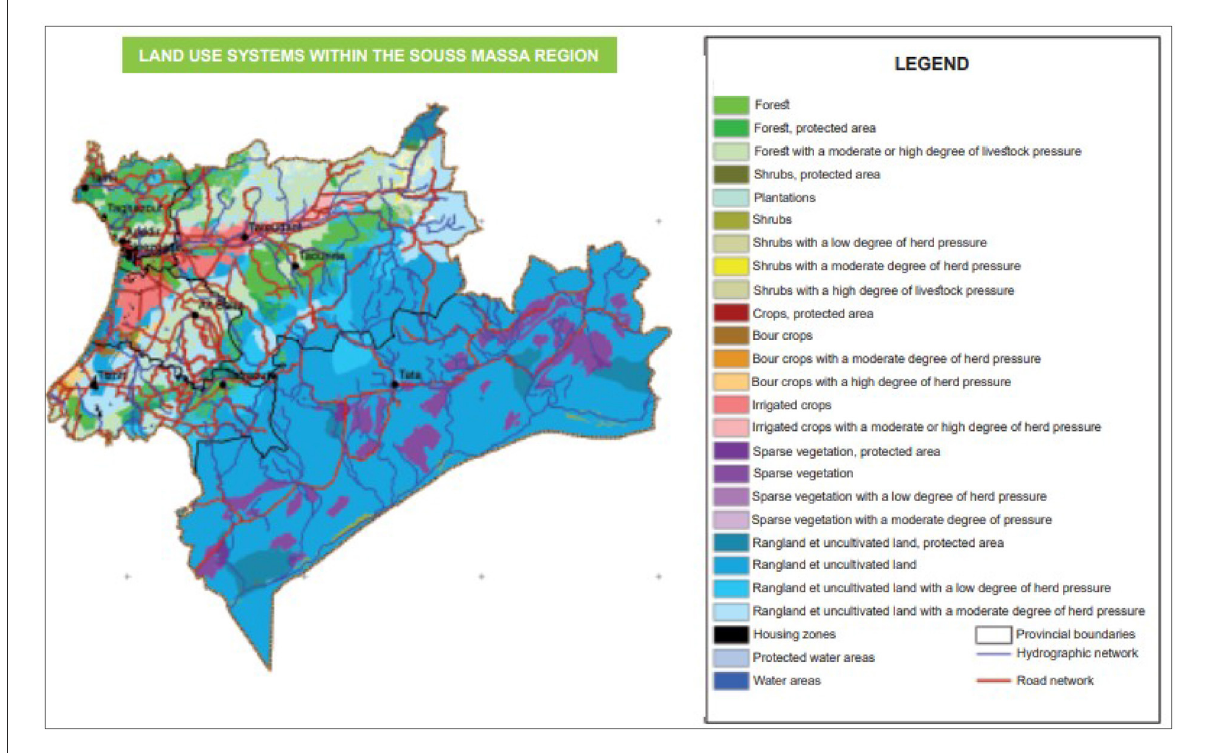
FIGURE6 Map of LUS in the Souss-Massa